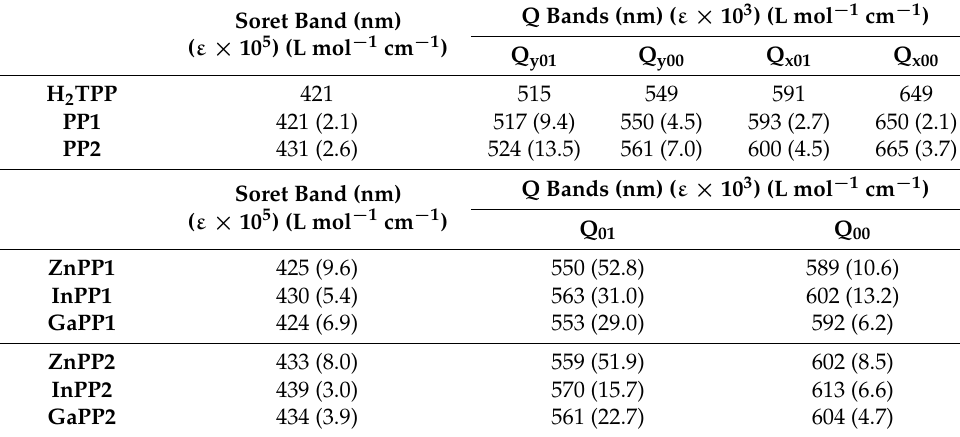
Table 1. The UV-visible absorption data for PP1 , PP2 and their metal complexes in toluene. Please note: the assignment of the Q bands (Q yo1 , Qy 00 , Q xo1 , Q x00 ) is shown in Figure 2. Soret Band (nm)